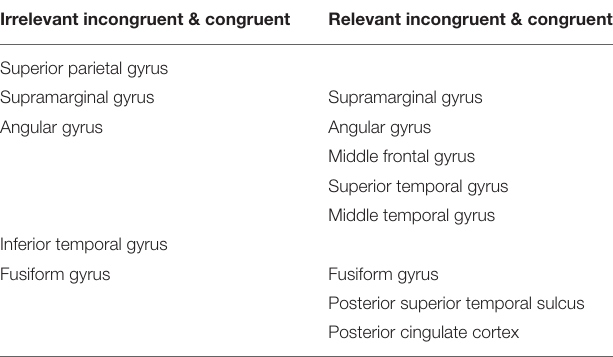
TABLE 2 | The anatomical location of different brain areas involved in the different states of incongruent information processing. Irrelevant incongruent &